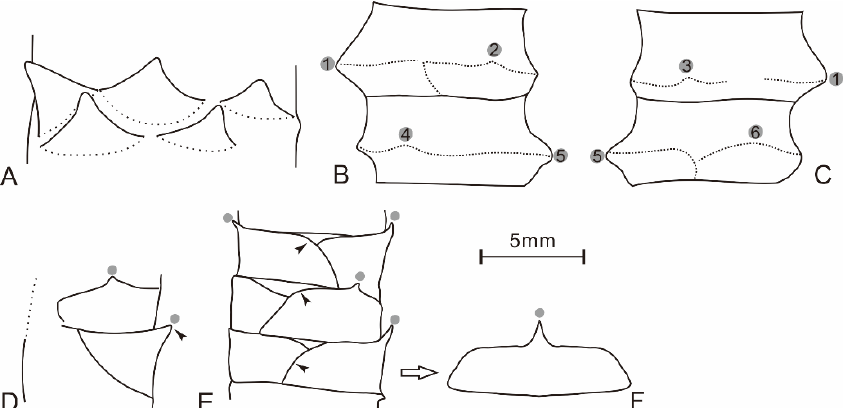
Figure 3. Line-drawings of Barsassia ornata [17] leafy stem based on materials from Middle Devonian Hujiersite Formation, West Junggar, Xinjiang, China. ( A ) From arrow 1 of Figure 1B, showing the fan-shaped leaves in surface view and the arrangement of leaves. ( B , C ) From Figure 1C,D. Dotted line indicates the leaf margin; the gray disks indicate leaf tips; and leaf tips are numbered and correspond in part and counterpart specimens. ( D ) From arrow 4 of Figure 1B, showing leaves in lateral view with tips (grey disks). ( E ). From arrowed portion of Figure 2B, showing the leaf in lateral view with obvious tip (gray disk) and the rectangular-shaped leaf. Black arrows show the leaf margin. The lateral leaf shows rectangular-shaped leaf after unfolding ( F ).